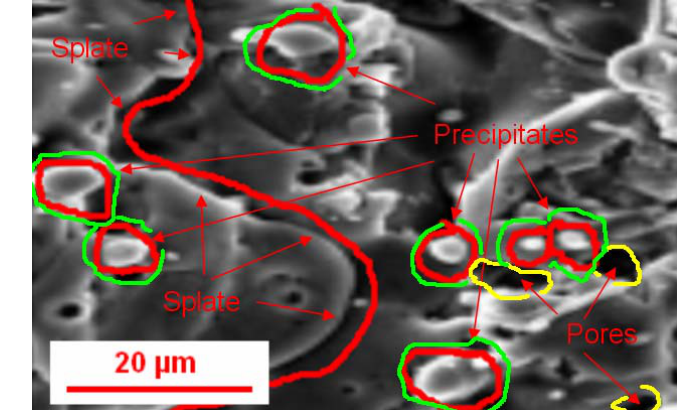
Figure 7 – Morphology surface of the Al 2 O 3 coating in the sprayed state, (900A) Рис . 7 – Морфология поверхности покрытия Al 2 O 3 , нанесенного напылением ,